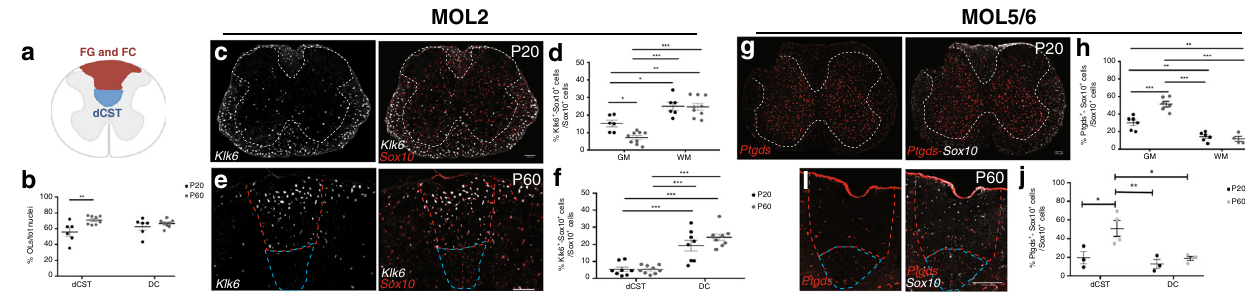
Fig. 2 MOL2 and MOL5/6 are speci fi cally enriched in adjacent regions of the juvenile and adult spinal cord. a Schematics of a coronal section of the spinal cord. Highlighted in blue and red the dorsal funiculi (white matter region) where ascending (FG and FC) and descending (dCST) tracts run, respectively. b Percentage of the OL lineage cells (Sox10 + cells) calculated on the total number of nuclei shows an enrichment of the OL lineage in the dCST with age. Data are presented as mean ± SEM. n = 6 − 8 animals per condition, and can be assessed in the Source Data fi le. c , e Confocal representative images show the enrichment of MOL2 ( Klk6 + OL lineage cells) in the white matter of the spinal cord ( c ) at postnatal day (P) 20 and at the level of the dorsal columns at P60 ( e ). g , i Confocal representative images show the enrichment of MOL5/6 ( Ptgds + OL lineage cells) in the gray matter of the spinal cord at P20 ( g ) and in the dorsal corticospinal tract at P60 ( i ). Scale bar = 100 μ m. d , f , h , j Quanti fi cation of the MOL2 and MOL5/6 distribution in the white and gray matter of the spinal cord ( d , h ) and dorsal funiculi ( f , j ) in juvenile (P20) and adulthood (P60). Percentage of the population is calculated on the total number of OL lineage cells ( Sox10 + cells) in the analyzed region. Data are presented as mean ± SEM. n = 3 − 9 animals per condition, and can be assessed in the Source Data fi le. Asterisks in all the panels in this fi gure indicate a signi fi cant difference between conditions (* p ≤ 0.05, ** p ≤ 0.01, *** p ≤ 0.001, two-way ANOVA with Sidak ’ s correction with multiple comparisons). Exact p values are reported in the Source Data fi le. Black circles — P20; Gray circles — P60. GM gray matter, WM white matter, FG fasciculi gracilis, FC fasciculi cuneatus, dCST dorsal corticospinal tract. MOL mature oligodendrocyte. Source data are provided as a Source Data fi